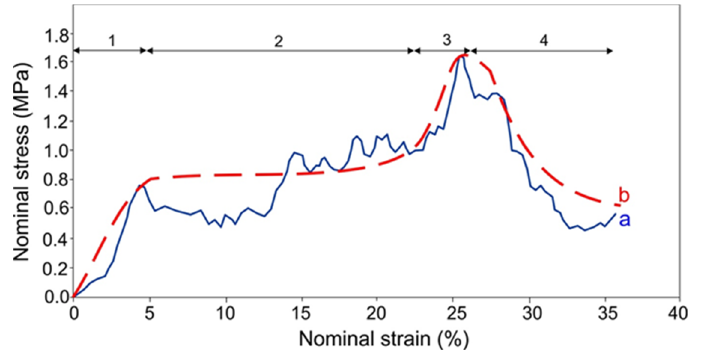
Figure 6. Stress-strain curves of the Ti-10 wt% 45S5 Bioglass-1 wt% Ag nanocomposite foam. Solid line—original curve ( a ) and dashed line of fitted curve ( b ); deformation stages are shown for fitted line (see description in text).